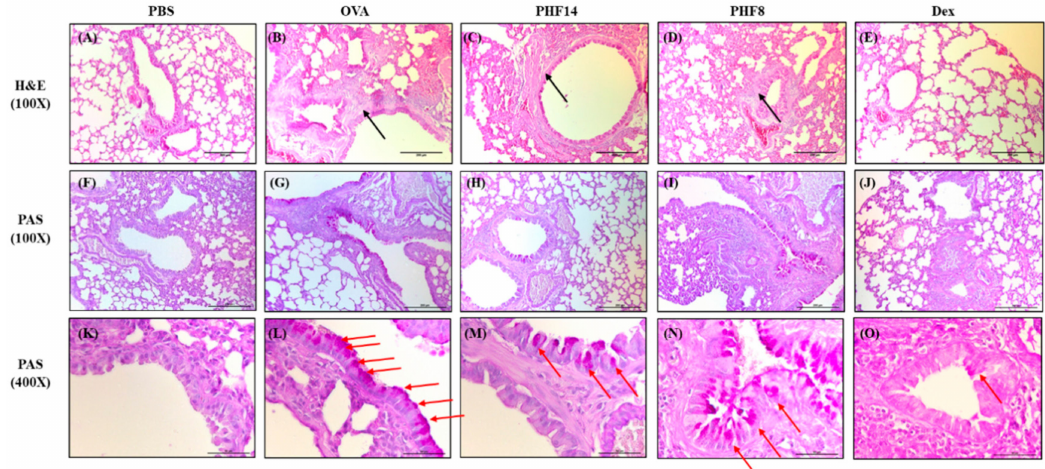
Figure 1. Effects of oral treatment of Pentaherbs formula (PHF) on airway remodeling of the